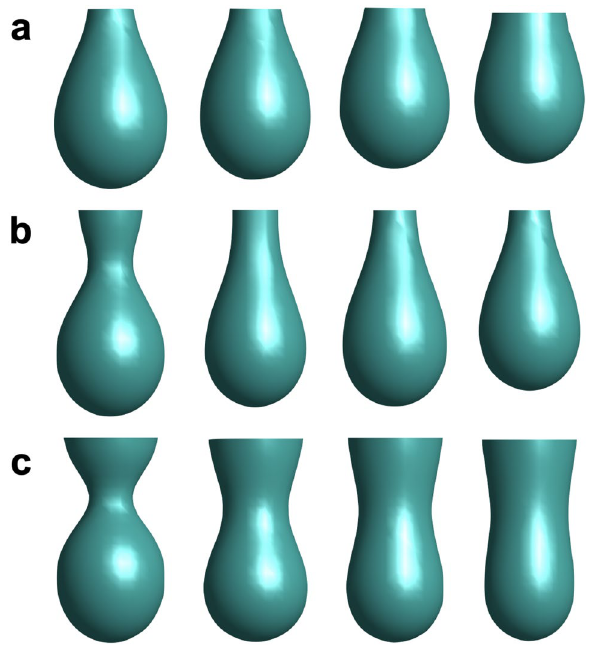
0 for different values of R obtained form the numerical integration of Eq. = 10 6 , 10 6 and 2 10 6 dt interactions. In ( a ) R × ×